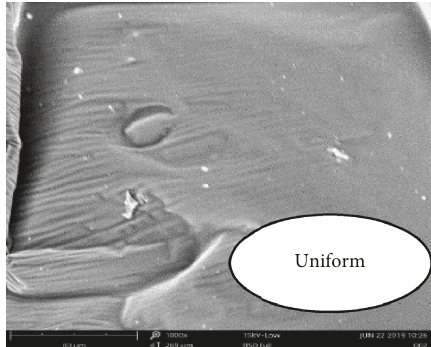
Figure 9: 5% of Buton-modified asphalt.